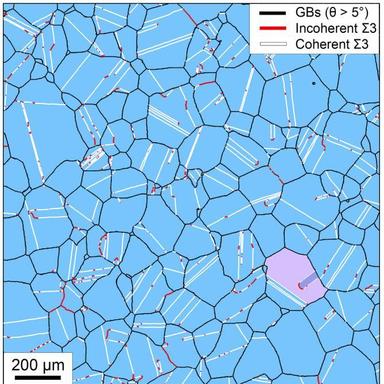
Phase boundary map with random GBs with misorientation θ > 5◦ (coloured black), incoherent Σ3 (coloured red) and coherent Σ3 boundaries (coloured white) of solutionised and aged Alloy 1. The grains that are used to illustrate the methodology in the other figures of this section are marked in purple.